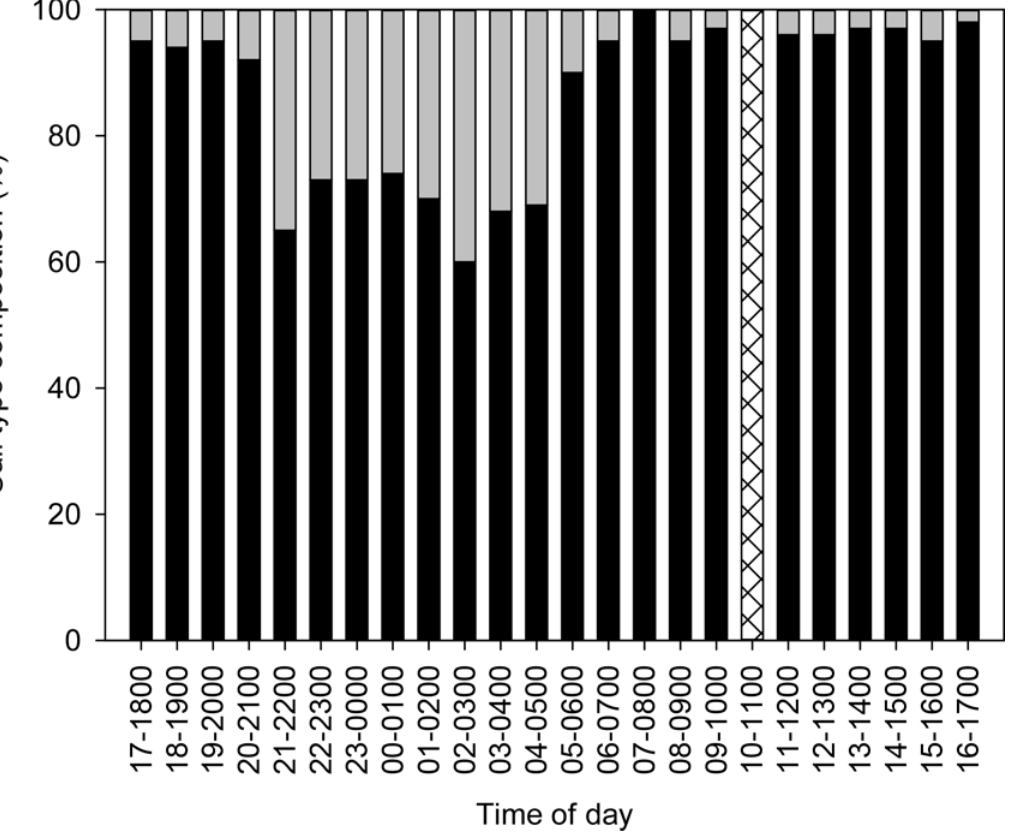
Fig 3. Diel variation in the proportion of grunt and growl type sounds. Grey vertical bar are growls and black vertical bar are grunts. Bar represents mean values observed in the hourly interval over five non-consecutive days of sampling. Crossed bar at 0900 – 1000 hrs indicate no data due to activation of water